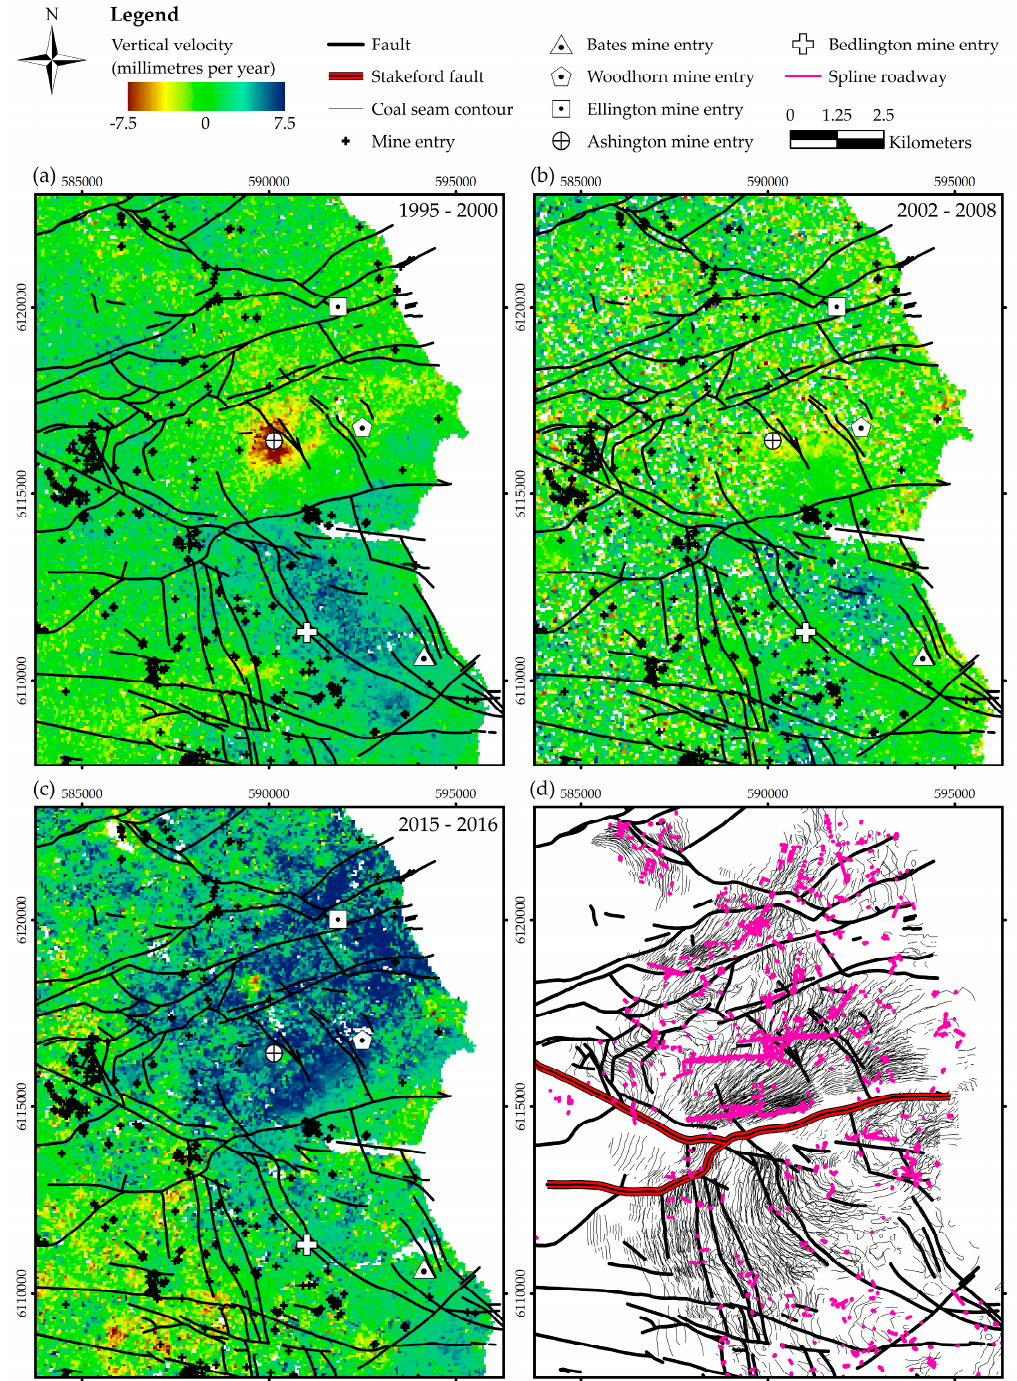
Figure 12. ISBAS vertical velocities (millimetres per year) in the surrounding area of Ashington with faults and mine entries overlaid: ( a ) ERS; ( b ) ENVISAT; ( c ) Sentinel-1; ( d ) Coal seam contours, faults and spline